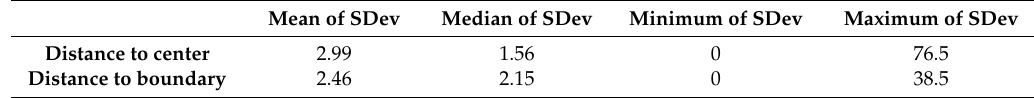
Table 4. Summary of the locations’ consistency of amenities in buildings that contain at least three POIs.